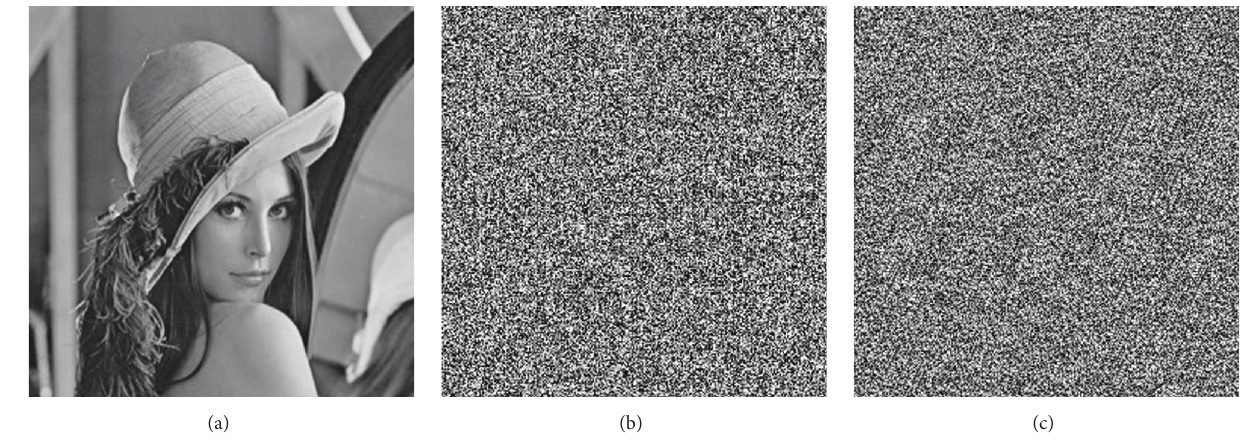
Figure 6: Experimental results of the wrong Key.